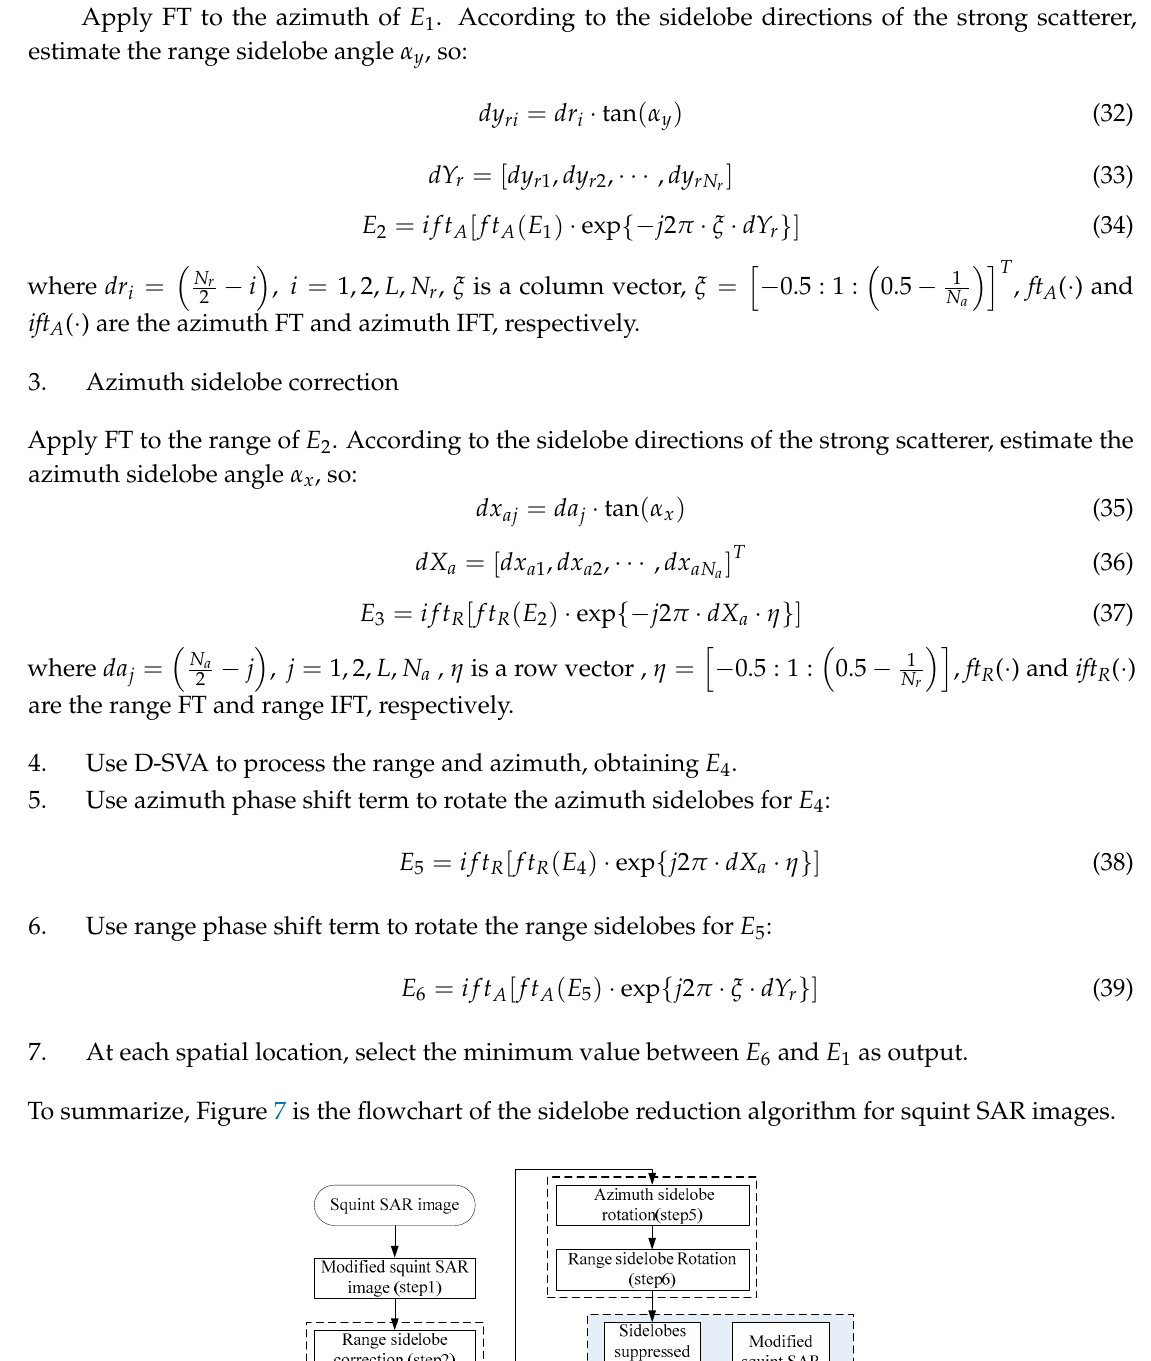
Table 1. Simulation parameters.